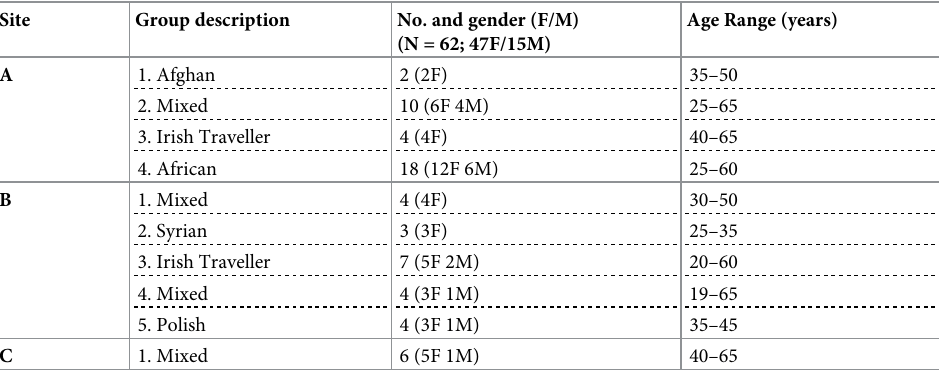
Table 3. Description of GP